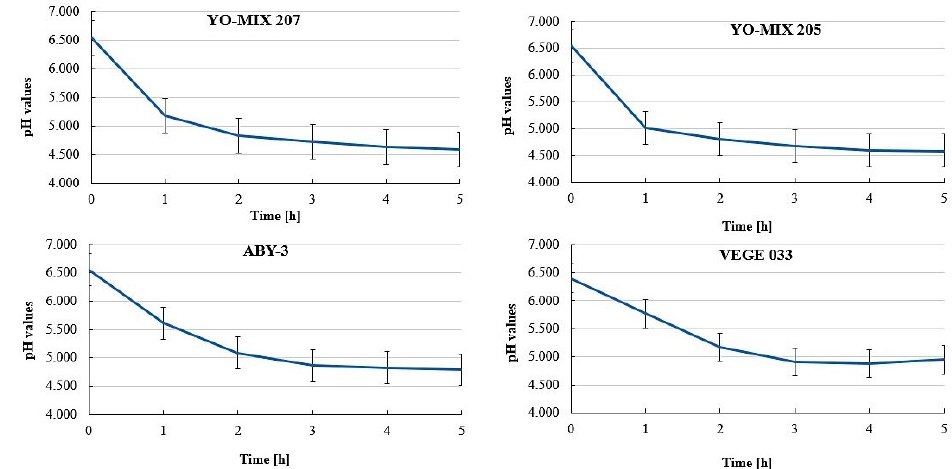
Figure 1. Acidification curves of buckwheat beverages during the fermentation process (mean values and standard deviations, n = 3).